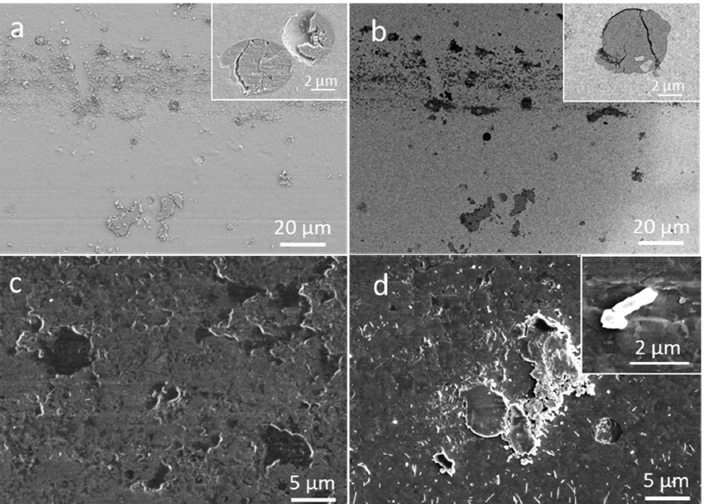
Figure 15. Secondary electron image ( a ) and backscattered electron image ( b ) of a wear track formed in BAI TiN coatings during a reciprocating sliding test performed in the ambient air; the anchoring points for wear debris and counter-body material transfer are depressions (see insets) as well as growth defects on the coating surface. SEM images of the wear track formed in AIP TiN coating during a reciprocating sliding test performed in the ambient air ( c , d ); the anchoring points for wear debris and counter-body material transfer are protrusions at the site of carbides ( c ), as well as broken nodular defects ( d ); roll-like debris are also visible in SEM image ( d ). Measurements on the alumina counterparts were also performed. 3D profile images of counterpart wear scars shown in Figure 16 reveal the existence of transfer layers on the ball sliding surface for all testing atmospheres. While the wear of the ball surface was similar for all three atmospheres, the amount of material transferred to the ball surface was the highest in the oxygen atmosphere and the lowest in nitrogen. As is evident from Figure 16, the lower wear of the coating in the nitrogen atmosphere was reflected in the lower transfer of material to the alumina ball. The tribofilm on the worn alumina surface was composed of the particles generated from both surfaces. Due to the high pressure and high temperature in the sliding contact, the wear particles were pressed together and sintered in the form of a tribofilm.